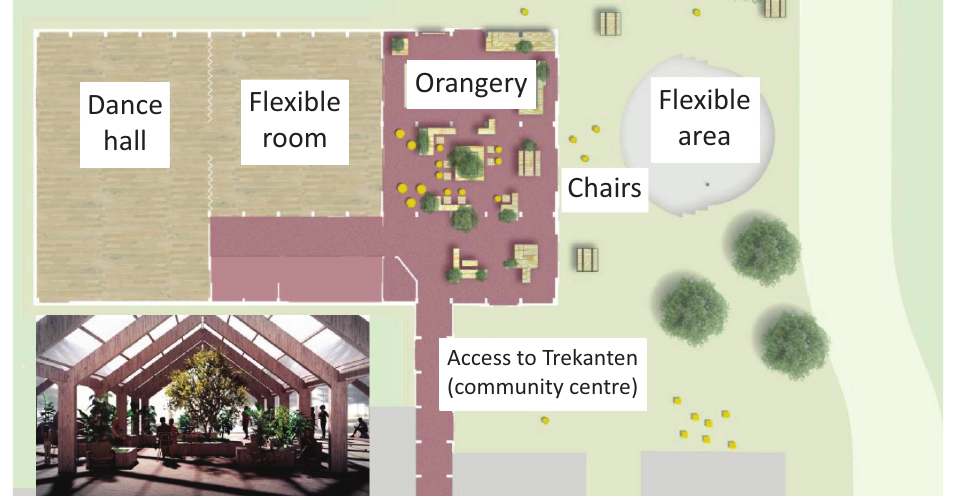
Figure 2. Plan and design of the Lanterna. Note: The lower left‐hand corner illustrates the vision of an open, transparent, and inviting design. Source: Authors’ work based on LINK Arkitektur (2022). incomes, and low educational levels (Dansk Politi, 2016).